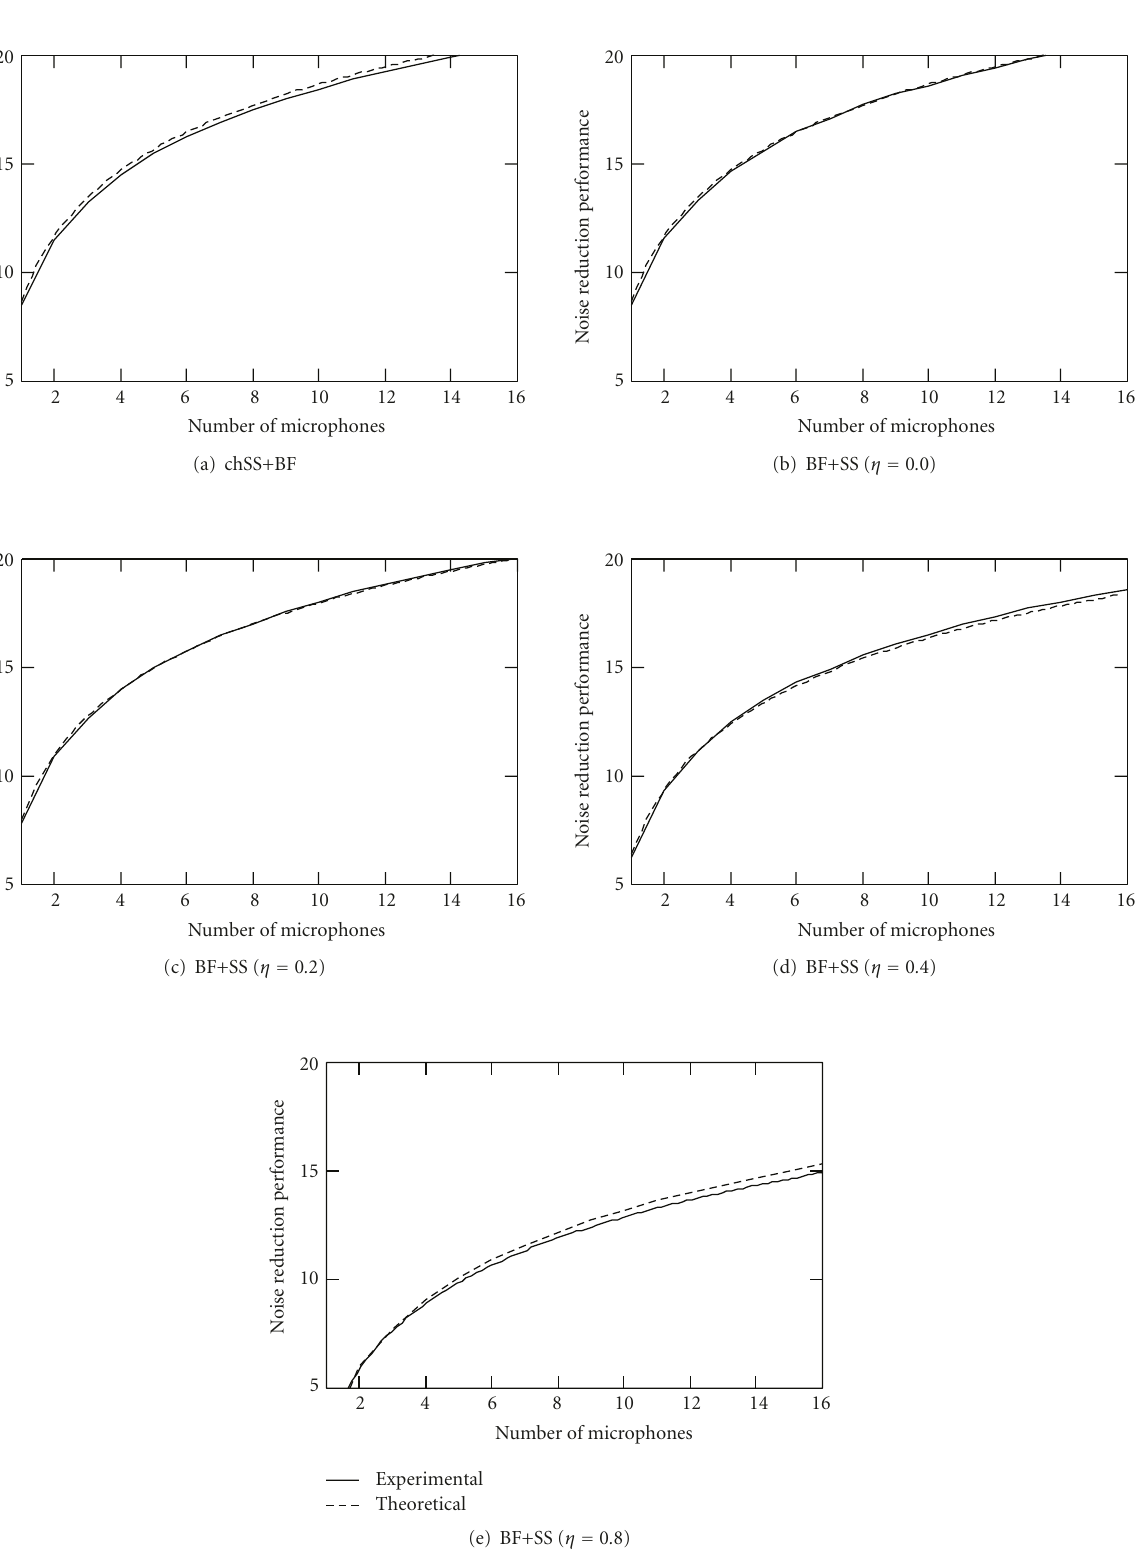
Figure 17: Comparison between experimental and theoretical noise reduction performances for Gaussian input